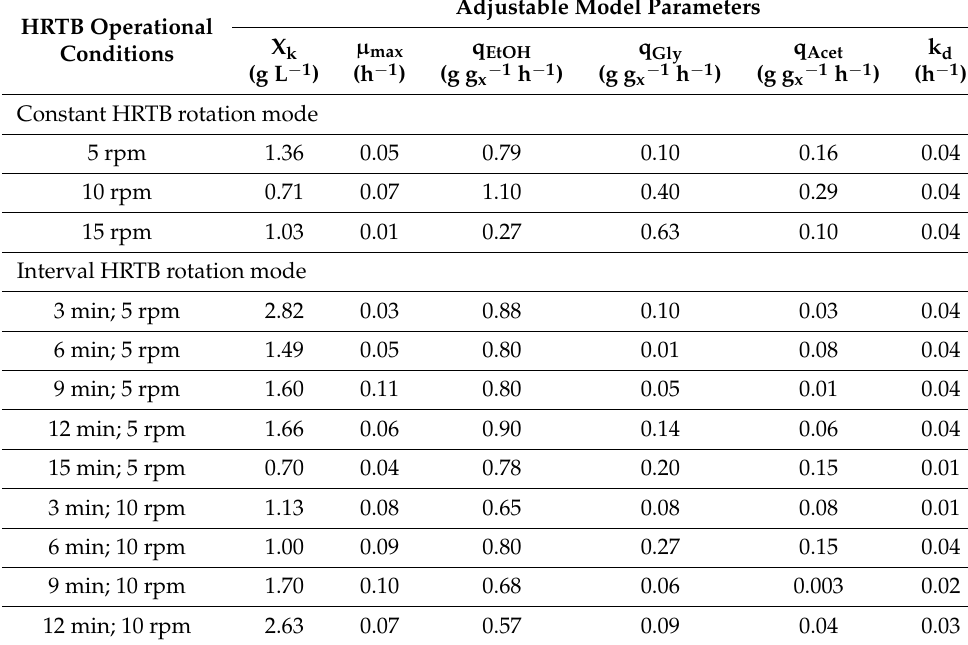
Table 3. Adjustable model parameters obtained during simulation of bioethanol production in the HRTB under different operational